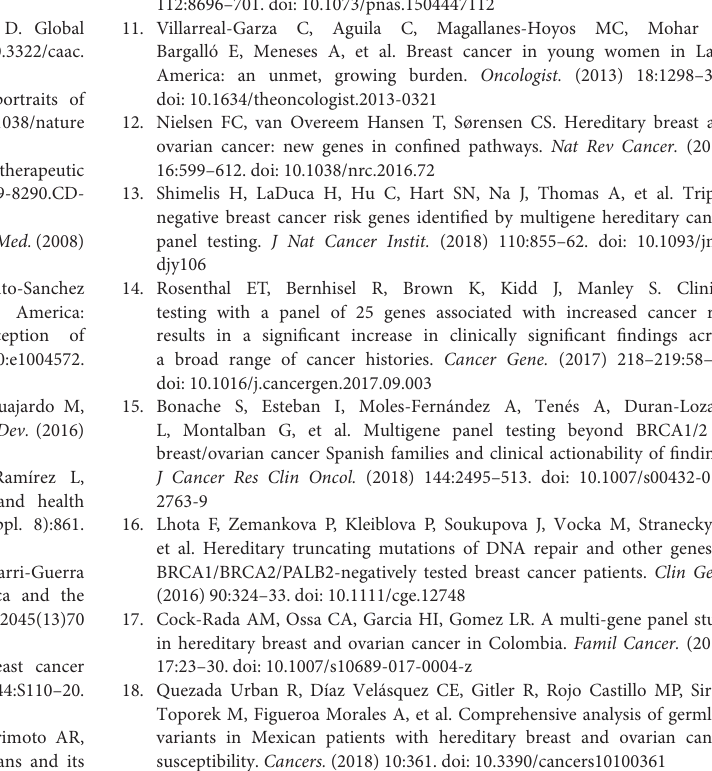
Supplementary Figure 1 | Global distribution of the mean sequencing depth. Histogram of sequence depth (X) with density of all sequenced samples. Mean depth is indicated. Supplementary Figure 2 | Distribution of the mean sequencing depth per country. Histogram of sequence depth (X) with density of all sequenced samples by country. Mean depth by country is indicated. Supplementary Table 1 | Variants with unknown clínical significance